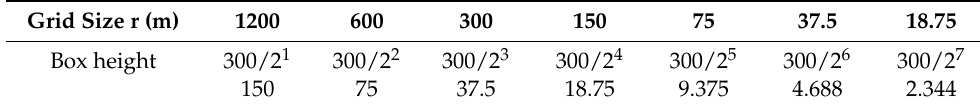
Table 2. Power law relationship between grid size r and 3D box height.